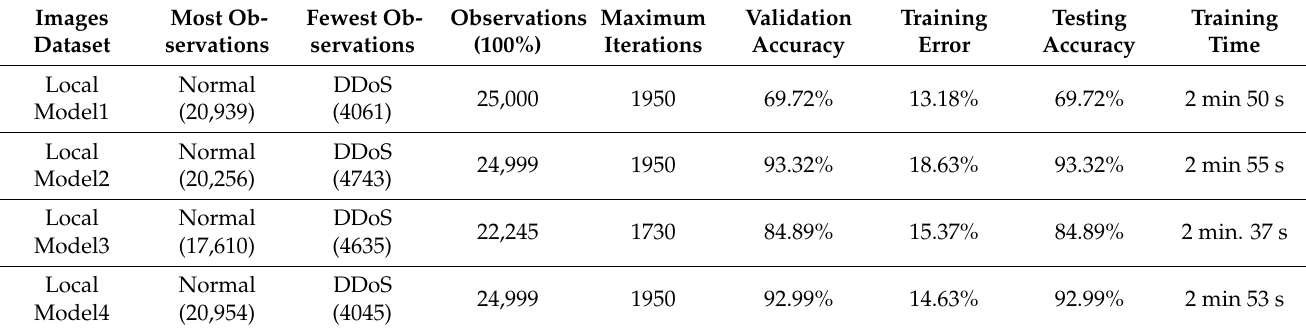
Table 3. Experimental results of the proposed FTL method and the 13-layer DNN.